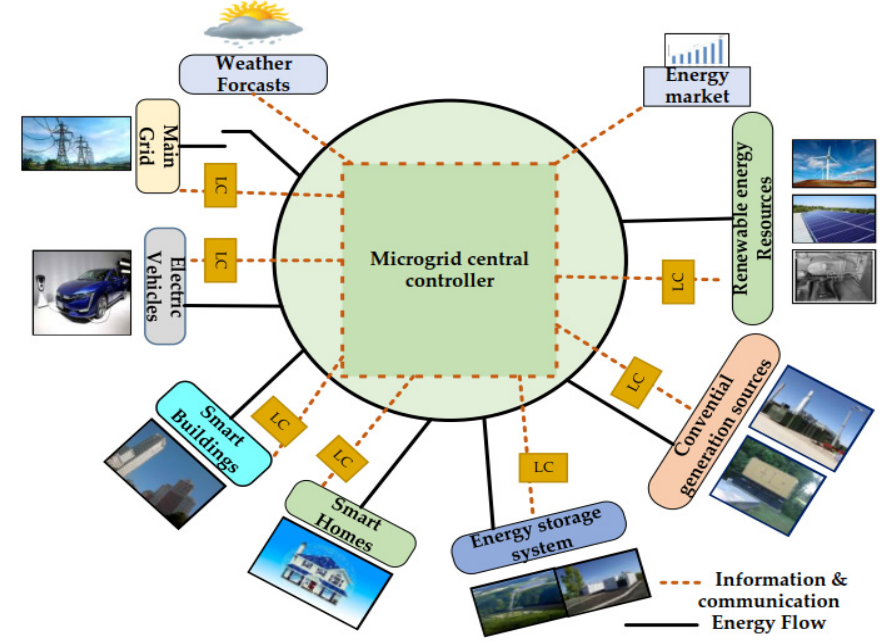
Figure 2. Microgrid setup. Table 1. Sustainable energy (SE) system in